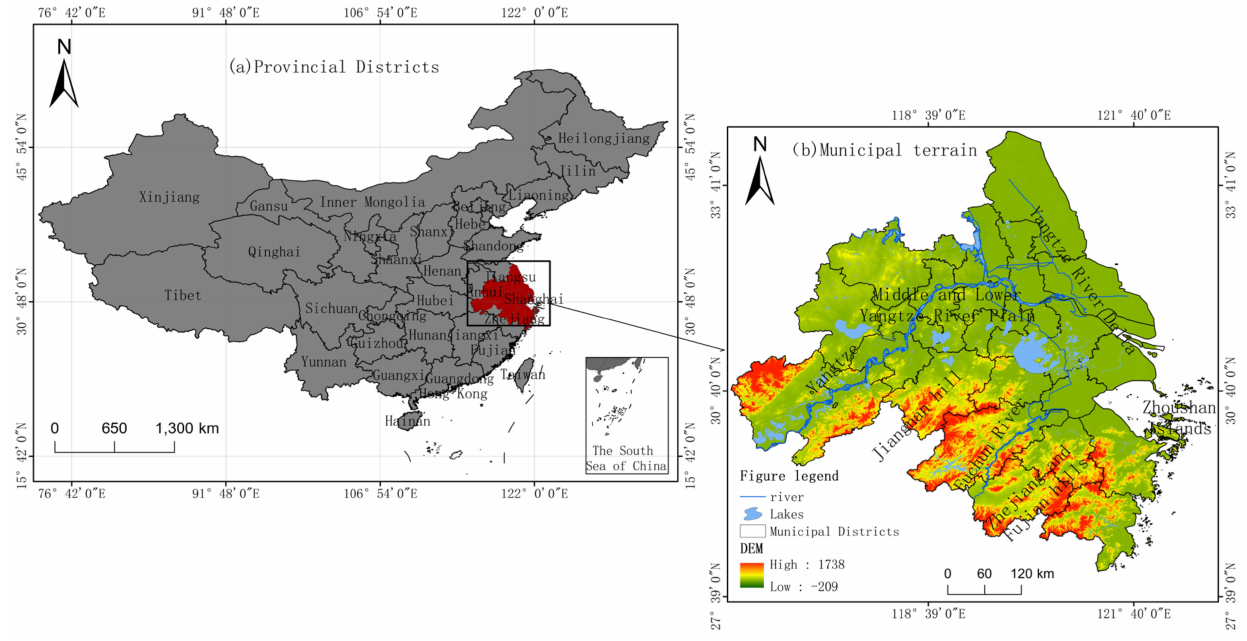
Figure 1. Overview of the study